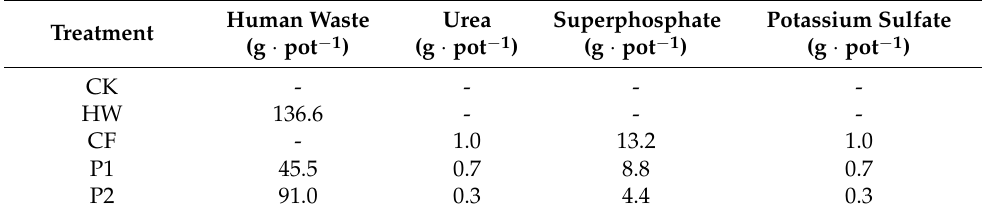
Table 1. Fertilizer application rates to soil in different treatments.